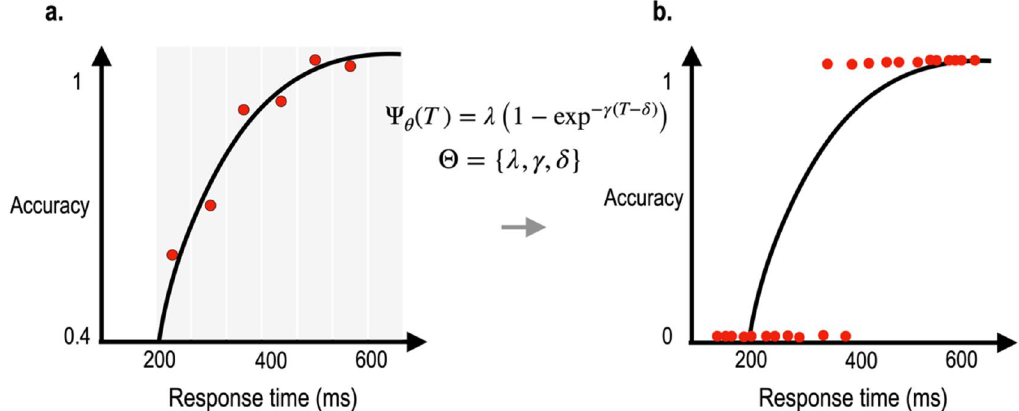
Figure 1. The binary decision problem for SAT. ( a ) Conventional SAT function estimation using a limited number of SOA (response time) bins and high-precision response accuracies for those bins. ( b ) Current SAT function estimation using responses’ binarized correctness at various response times or